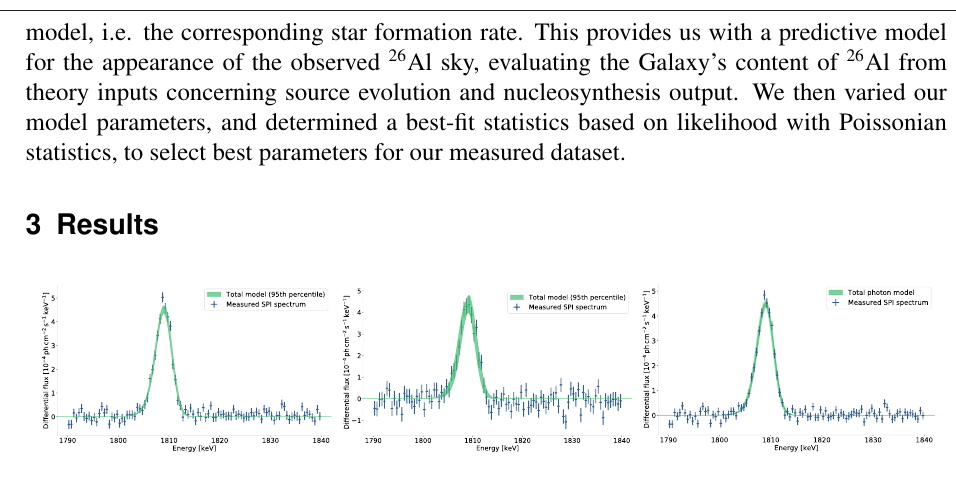
Figure3.25:SPIspectrum( blue datapoints)ofthe 26 Alfull-skyemissionat 1809 keV.Thebest-fittingphotonmodelisshowninbandsof 1  , 2  ,and 3  confidenceintervalsinshadesof green fromdarktolight. ItrepresentsadegradedGaussianlineprofileontopofapower-lawcontinuum(cf.Eq.3.28).IndividualspectralparametersaregiveninFig.3.24andTab.3.3. Thetotalfluxofthesignalis Figure 1. The energy spectrum around the 26 Al line, as obtained from single-hit events (left), double- F 26 Al =(1 . 87 ± 0 . 03) phcm  2 s  1 withadetectionsignificanceof 58  . characteristicsasdescribedinSec.3.4.1aredepictedinFig.3.26. Thelineshows hit events (middle), and combined events (right) of our observations. Data points represent the mea- an overall width of FWHM tot = 3 . 23 +0 . 07  0 . 06 keV with a shift of the central energy  E cen =(0 . 29 ± 0 . 04) keVwithrespecttotherestenergyofthe 26 Alemissionlineof 1808 . 73 keV(Endt1998).Incombinationwiththeuncertaintyoftheenergycalibra- surement, with bin width and Poissonian statistical uncertainty indicated. The uncertainties shown in shaded green have been derived from MCMC modelling of the spectral response, and show 3 σ varia- tions around the FigureA.4:SpectralMCMCfitresultsforthefull-skyemissionof 26 Alat 1809 keVmeasuredwithSPIdoubleevents separately. Upper: EquivalenttoFig.3.24. Middle: EquivalenttoFig.3.25. Lower: Equivalentto FigureA.3:SpectralMCMCfitresultsforthefull-skyemissionof 26 Alat 1809 keVmeasuredwithSPIsingleevents separately. Upper: Equivalent to Fig. 3.24. Middle: Equivalent to Fig. 3.25. Lower: Equivalent to Fig.3.26. Fig.3.26.